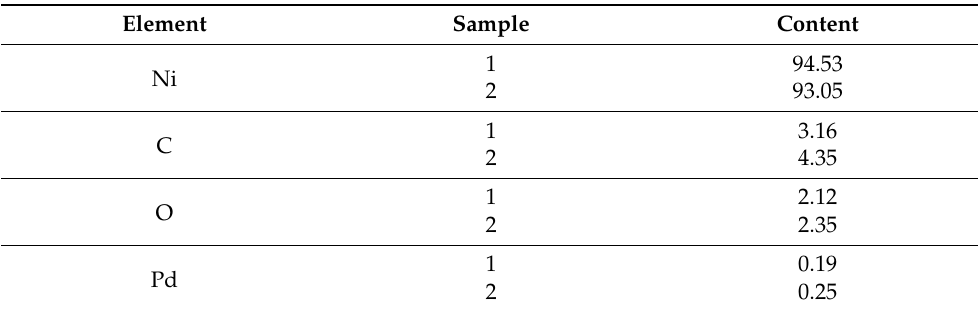
Table 1. An average, elemental content (wt.%), derived for palladium-modified Ni foam cathodes (samples 1 and 2) by means of EDX analysis.